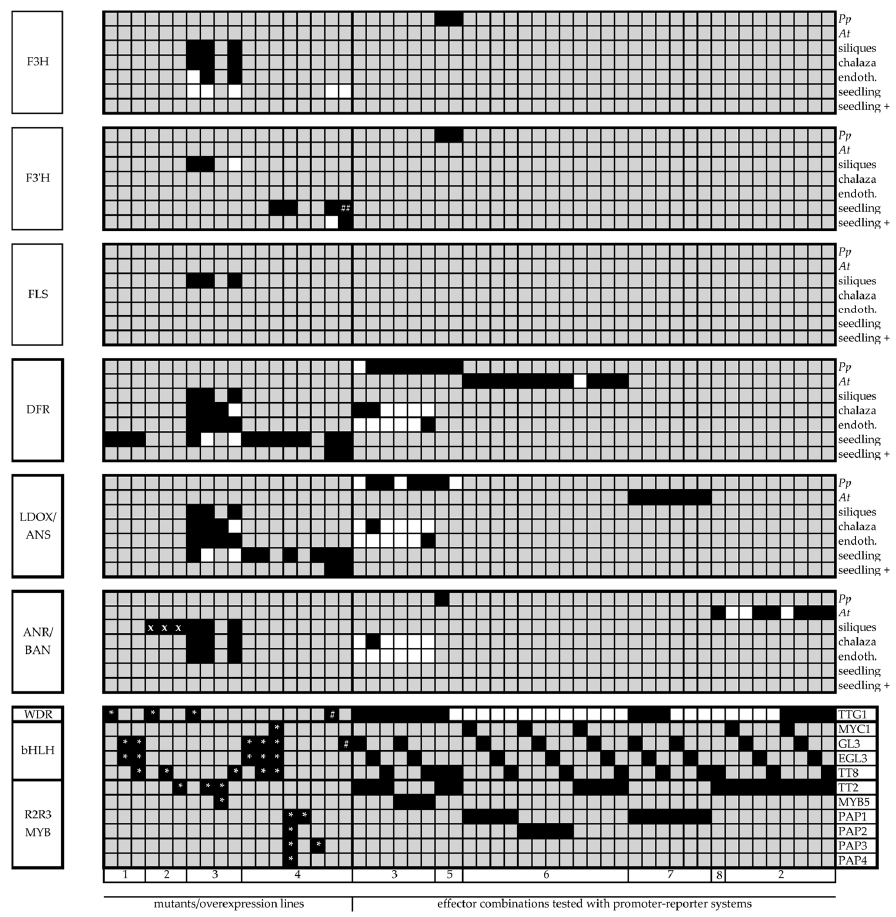
Figure 4. Tissue-specific MBW(AtTTG1) regulation of the flavonoid biosynthesis’ LBGs. Collection of exemplifying studies analyzing the flavonoids core enzyme’s regulation through MBW(AtTTG1) components. These comprise tissue-specific, mutant and promoter-reporter experimental approaches. Black boxes next to the MBW factors indicate the combinations of MBW factors, used mutants or overexpression lines in the respective experiment summarized above for the different LBG promoters. Black boxes next to the enzymes depend on the type of experiment. The respective enzyme’s promoter was either (1) upregulated by combinations of MBW factors or in MBW overexpression lines; (2) downregulated in the respective mutant; (3) induced upon DEX treatment combined with or without CHX when fusions with GR were used. White boxes: the respective promoter/transcript level was not significantly affected in the experiment, and this was documented in the respective study. Grey boxes: not tested/no results presented in the respective study. Note the differential regulation based on complex composition, e.g., for AtTTG1-GL3/EGL3/TT8-TT2/MYB5 complexes in [115]. AtTTG1-GL3/EGL3/TT8-PAP are known to be relevant in vegetative tissue (e.g., [115,118]).